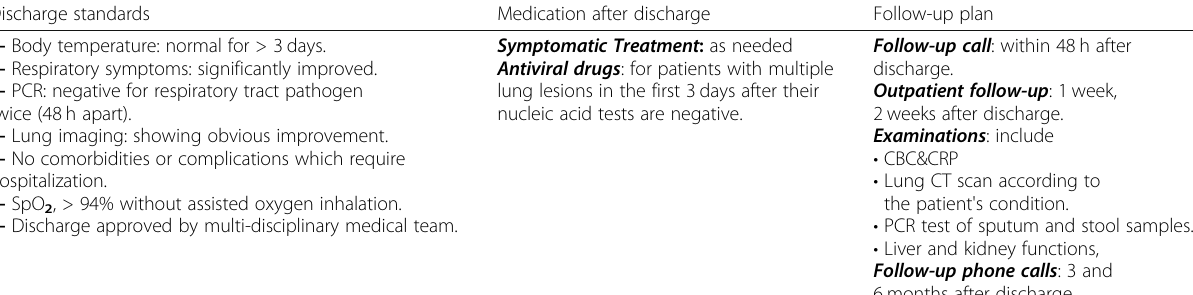
Table 4 Discharge standards and follow-up